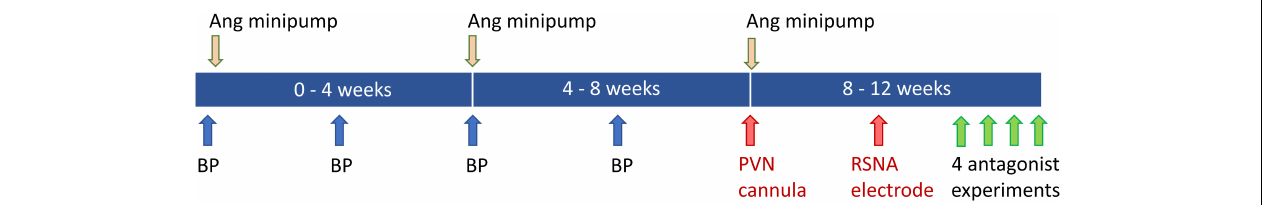
Frontiers in Physiology |